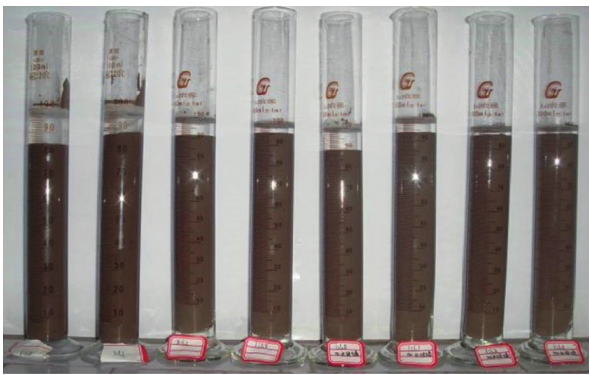
Figure 10: Slurry with different mixing proportion.